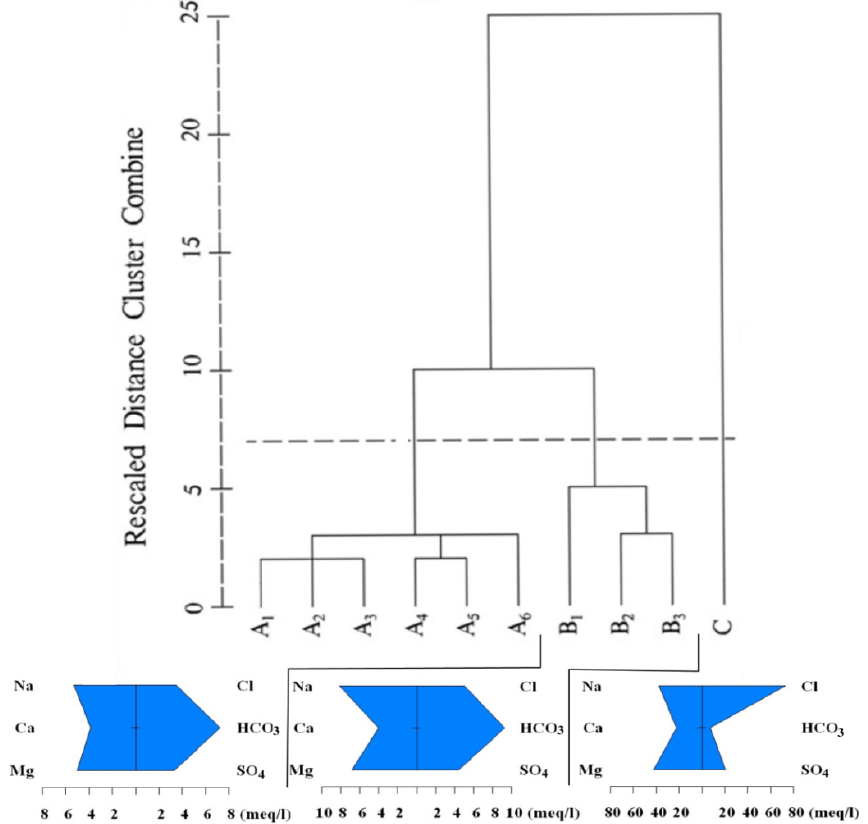
Figure 8. Dendrogram from cluster analysis (Q-mode) of water samples showing the division into three clusters and the stiff diagram of mean concentrations for each cluster.